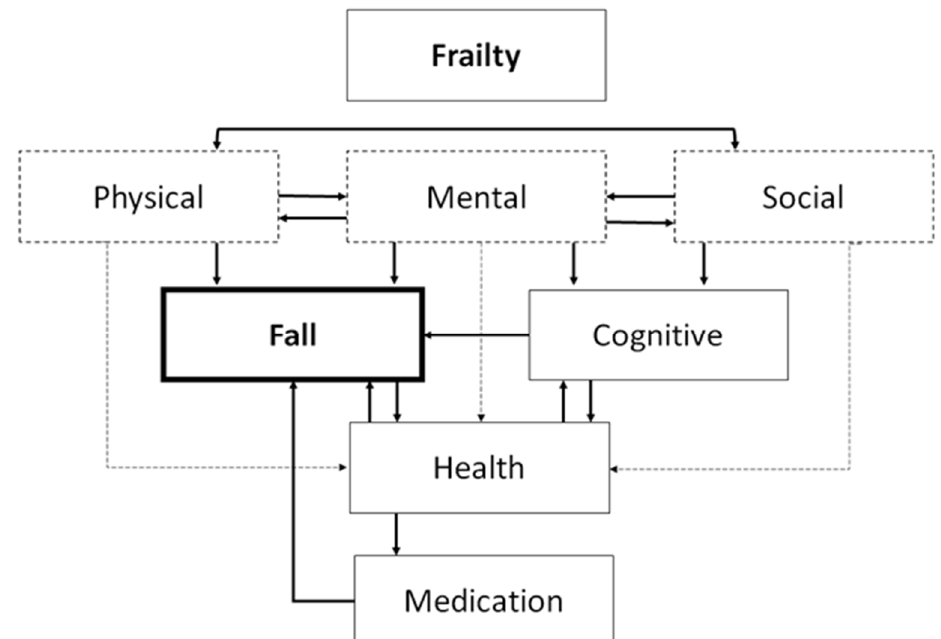
Figure 1. Diagram of frailty, falls and associated elements.